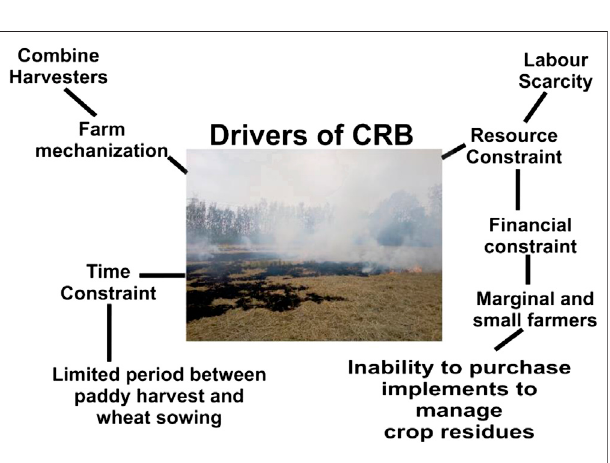
FIGURE 5 | Drivers of crop residue burning.